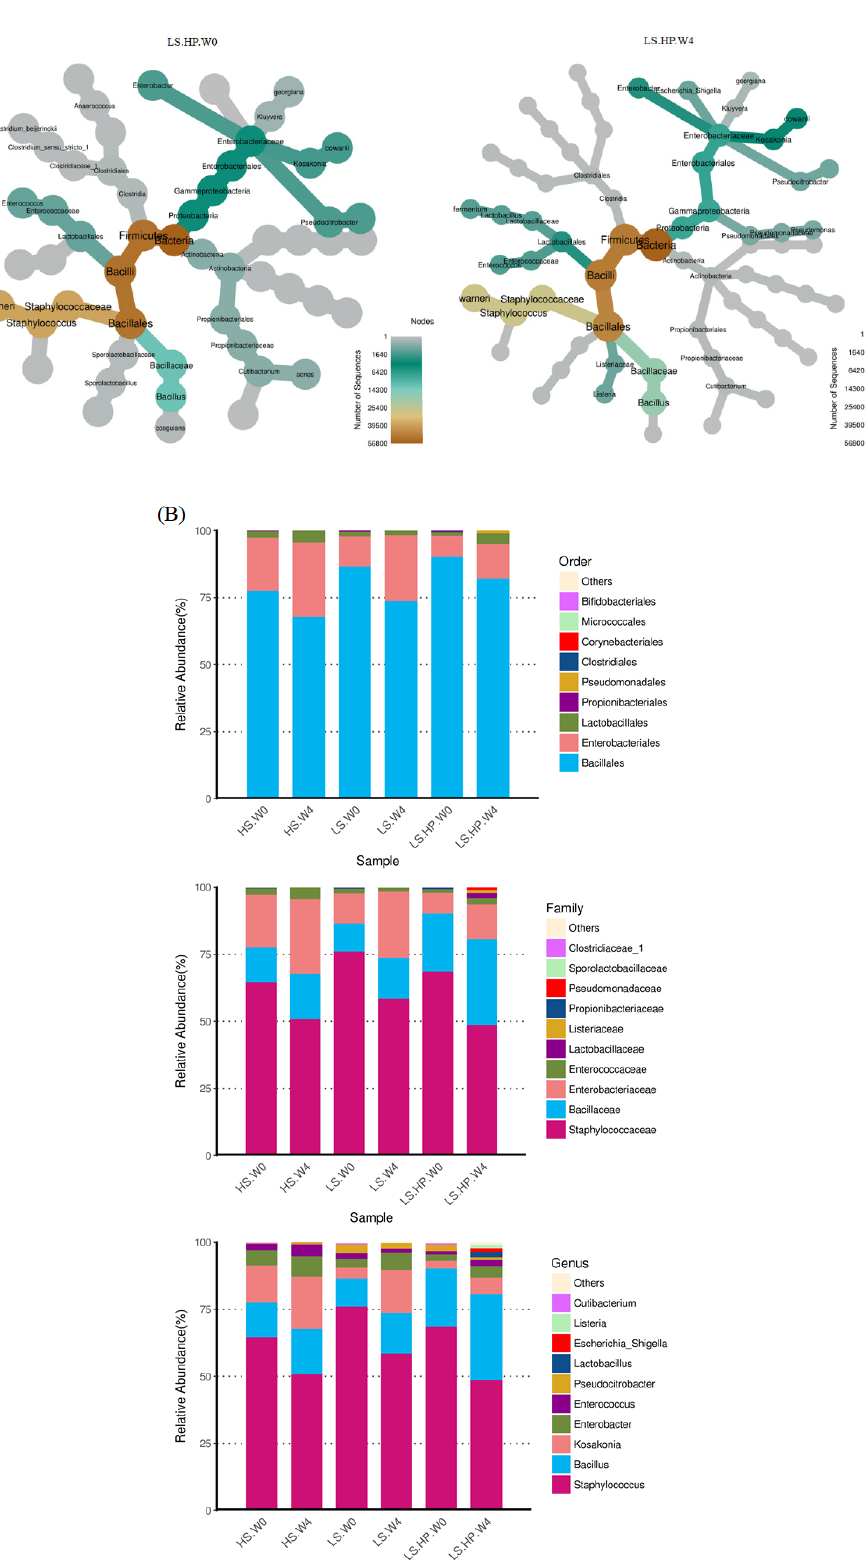
Figure 3. ( A ) The heat trees obtained from analysis of bacteria microbiota in high-salt (HS), low-salt (LS), and low-salt high-pressure (LS-HP) soy sauce during fermentation. ( B ) The relative abundance (%) obtained from analysis of bacteria OTUs in high-saline (HS), low-saline (LS), and high-pressure- treated low-saline (LS-HP) soy sauce during